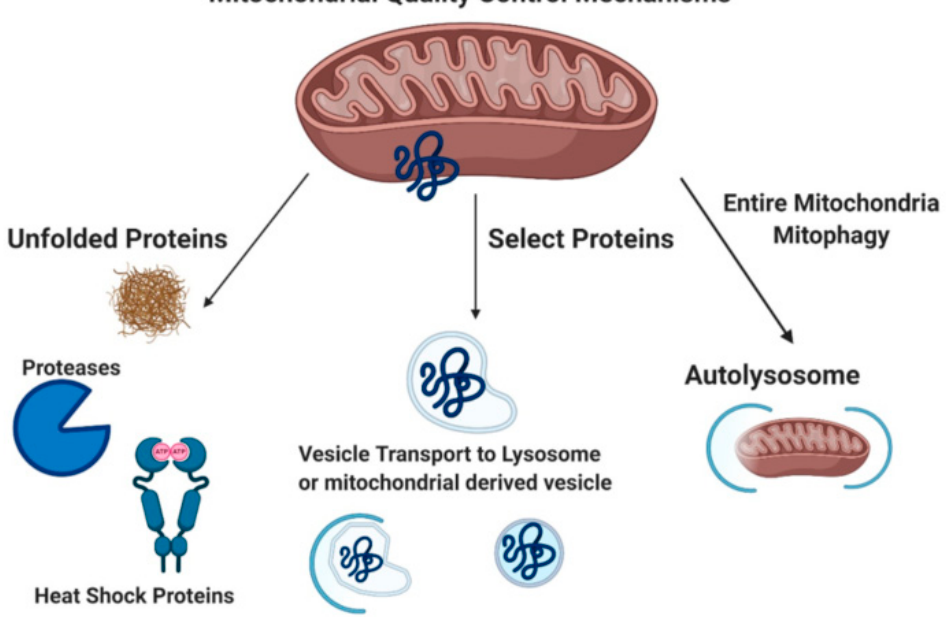
Figure 1. Mitochondrial Quality Control Mechanisms. Unfolded protein response, mitochondrial derived vesicles, and mitophagy [23,33] Created with